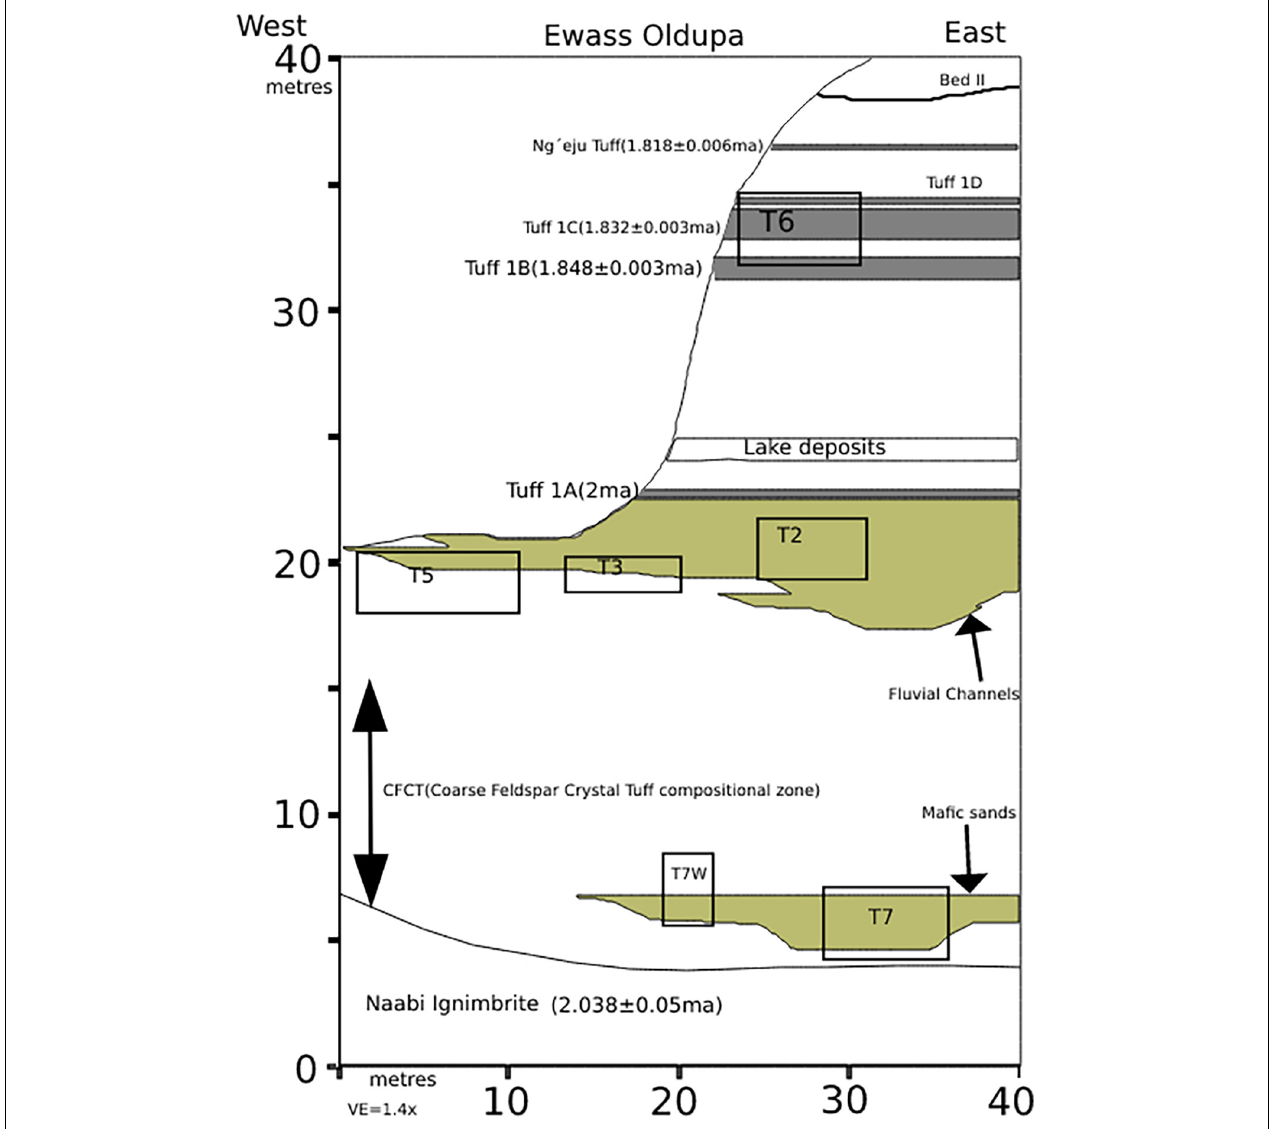
FIGURE 1 | Tuff dates and locations, sampled stratigraphic sections and excavated trenches at Ewass Oldupa. Figure indicating the date and location of tuffs, stratigraphic sections sampled and excavation trenches from Ewass Oldupa (modified from Mercader et al.,